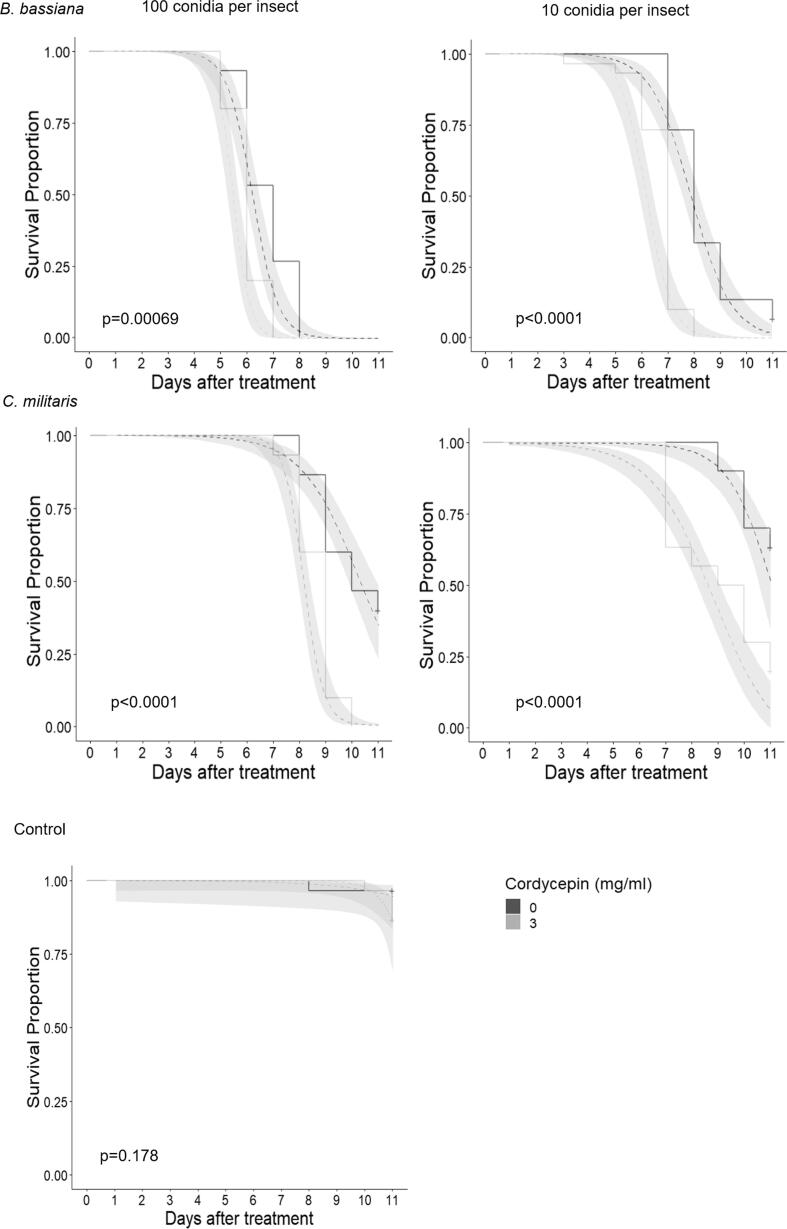
Survival curves of G. mellonella treated with cordycepin and EPF. Survival of G. mellonella larvae injected with 10 or 100 B. bassiana conidia or C. militaris conidia. Solid lines show observed mortalities, those lines ending in ‘+’ indicate censored populations. Dashed lines indicate the expected population decline (shaded area illustrates the standard error) estimated by fitting a binomial generalized logistic model. Pale grey lines indicate treatment with cordycepin (3 mg ml−1) and dark grey with a DMSO control. N = 30 per treatment. P values are the result of a log-rank test.